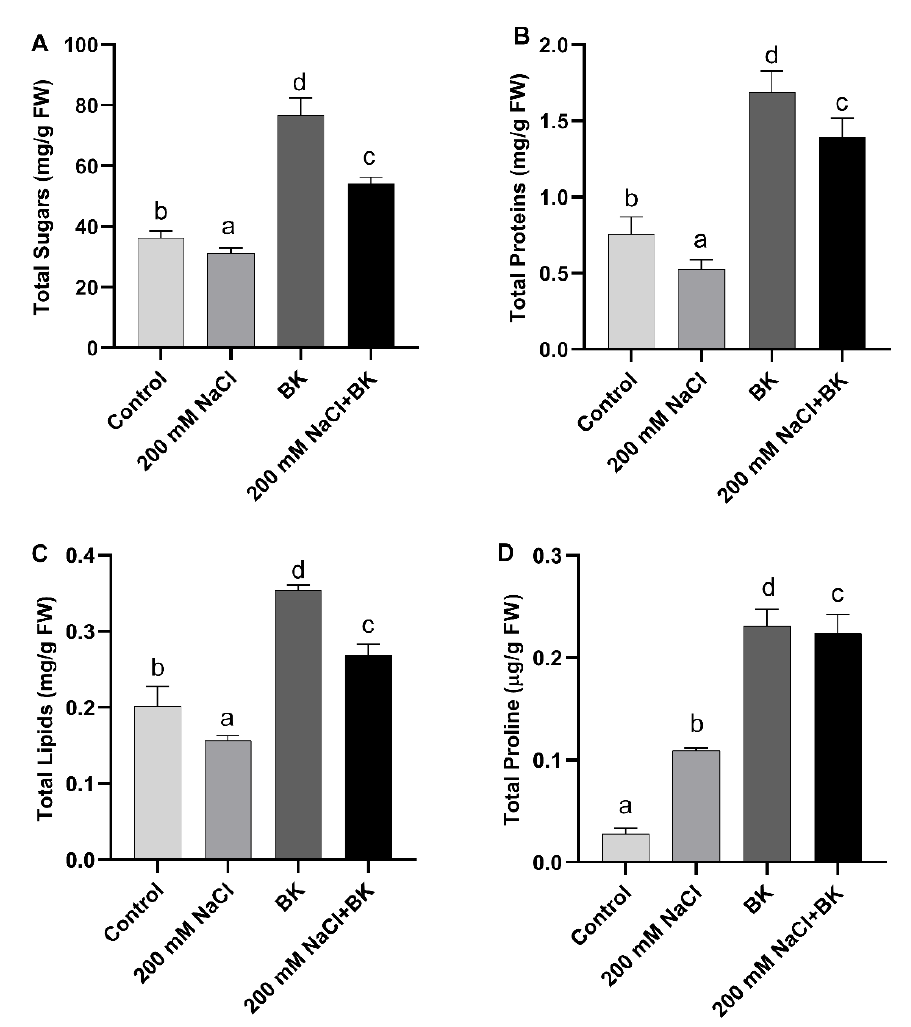
Figure 4. Influence of A. welwitschiae BK on primary metabolites. ( A ) Total soluble sugars, ( B ) total proteins, ( C ) total lipids, and ( D ) proline content of maize raised under salt stress. Data represent the means and SE of three independent replicates for each treatment. Significant differences ( p ≤ 0.05) are marked with different le tt ers.